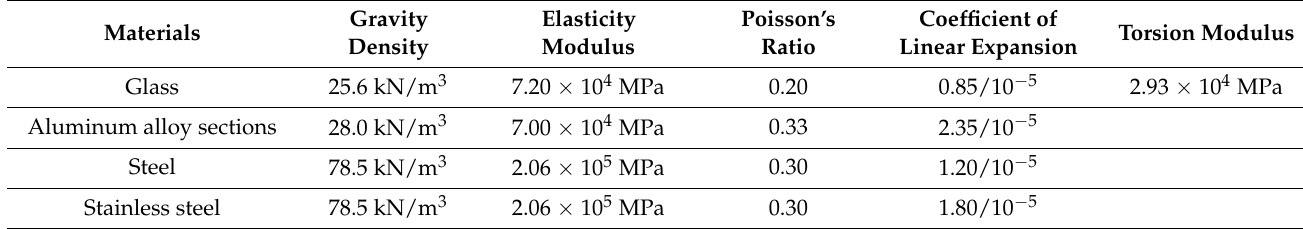
Table 1. Mechanical properties of curtain wall materials.